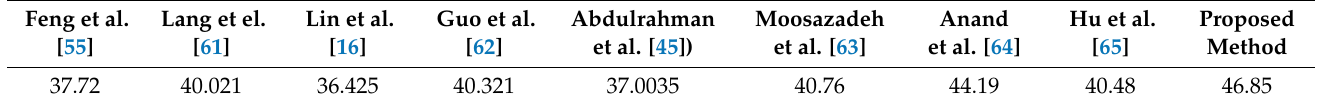
Table 11. Comparison of average PSNR (dB) values of the proposed with existing schemes. Feng et al. Lang et